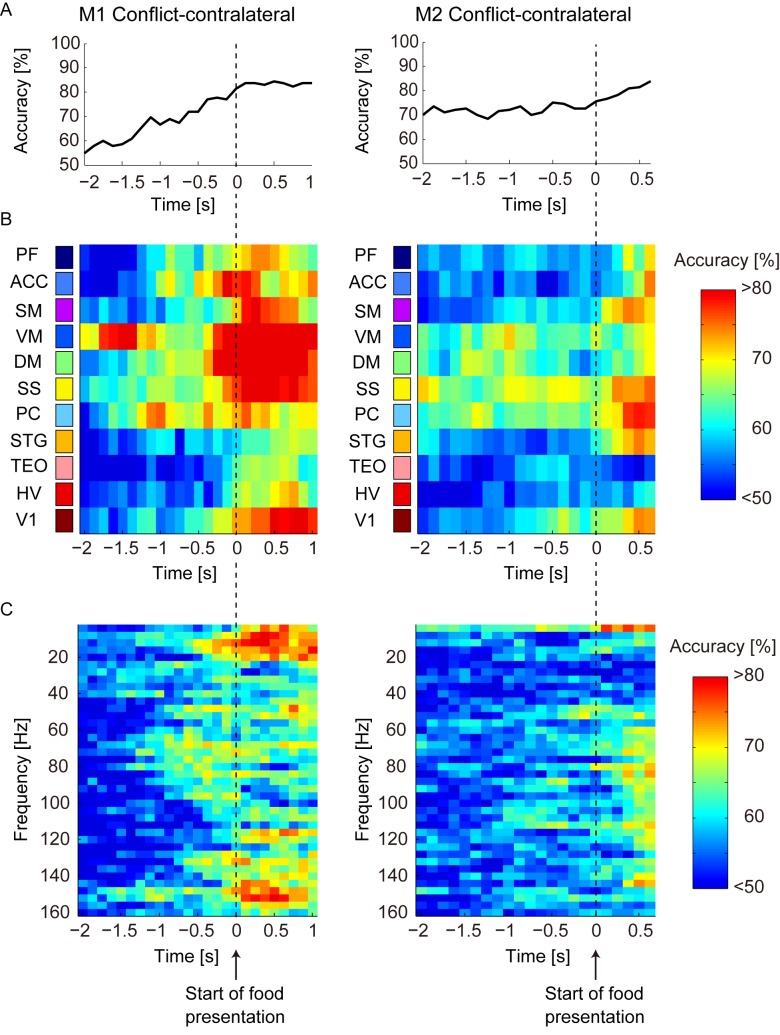
Accuracies of the temporal, spatiotemporal, and spectrotemporal neural classifiers.All figures are aligned to the start of the food-presentation period (vertical dashed lines). The range of time intervals used in the analysis was –3000 ms to 1000 ms for M1 and –3000 ms to 625 ms for M2. The numbers on the x-axis indicate the end of each long time bin. A: Temporal sequence of the accuracy of the temporal neural classifier in the conflict–contralateral condition. B: Temporal sequence of the accuracy of the spatiotemporal neural classifier in the conflict–contralateral condition. The color of the bars represents the accuracy of the classifier. C: Temporal sequence of the accuracy of the spectrotemporal neural classifier in the conflict–contralateral condition. The color of the bars represents the accuracy of the classifier.